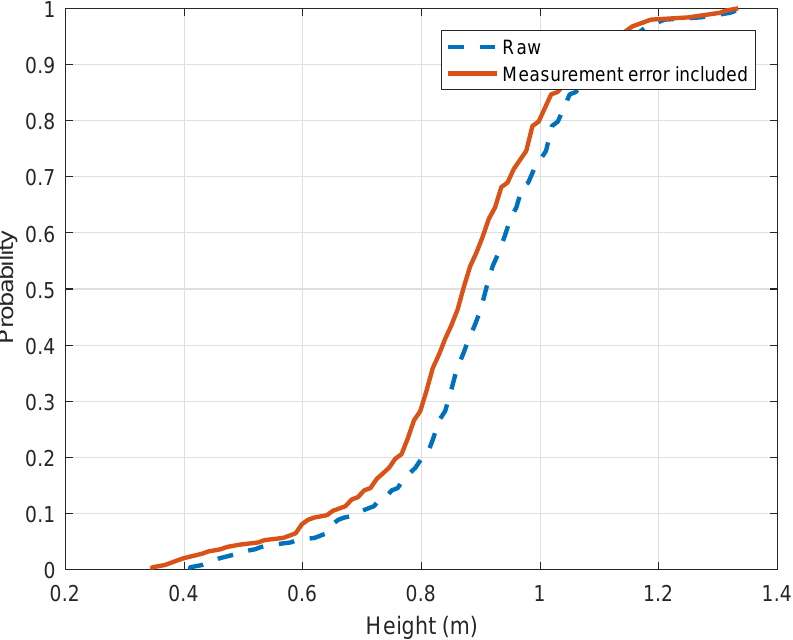
Figure 9. Empirical Cumulative Distribution of Height of the rear taillight lower